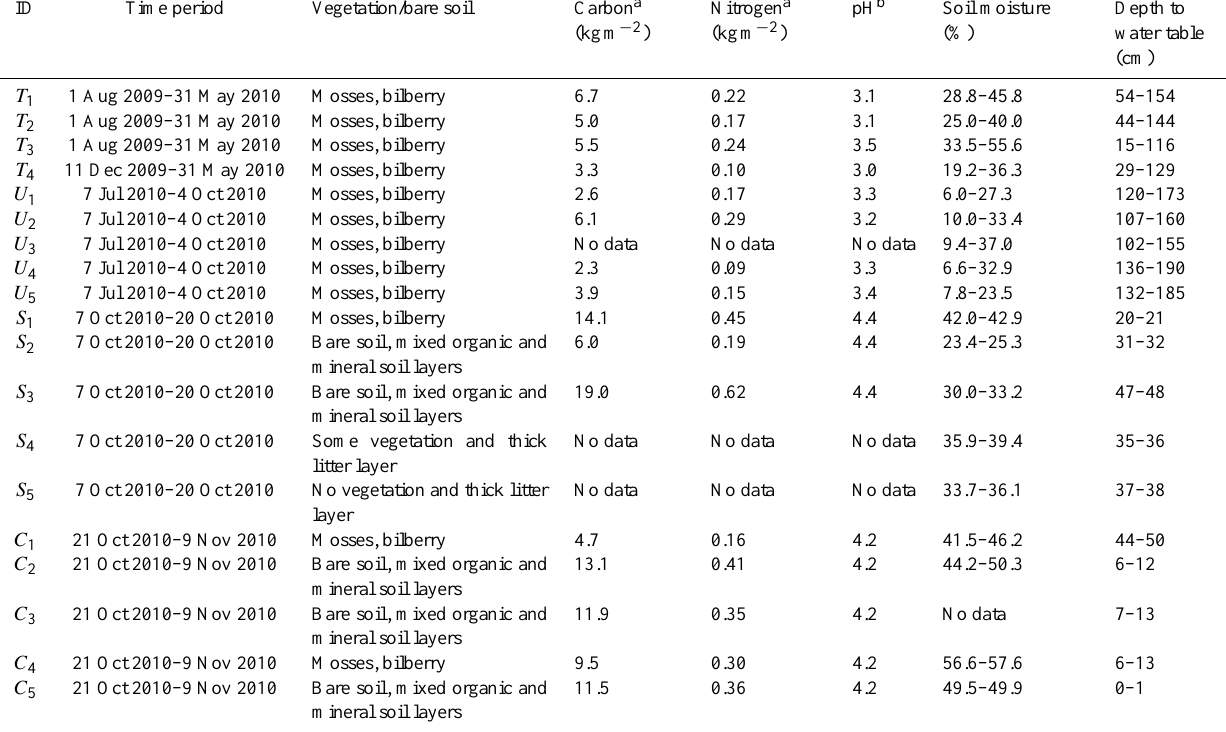
Table 1. Information regarding vegetation, C and N pool, pH, soil moisture (5th and 95th percentiles) and depth to water table at the individual chamber locations. Chamber locations were named U 1 – U 5 at the undisturbed plot, T 1 – T 4 at the thinned plot, C 1 – C 5 at the clear-cut plot and S 1 – S 5 at the stump harvested